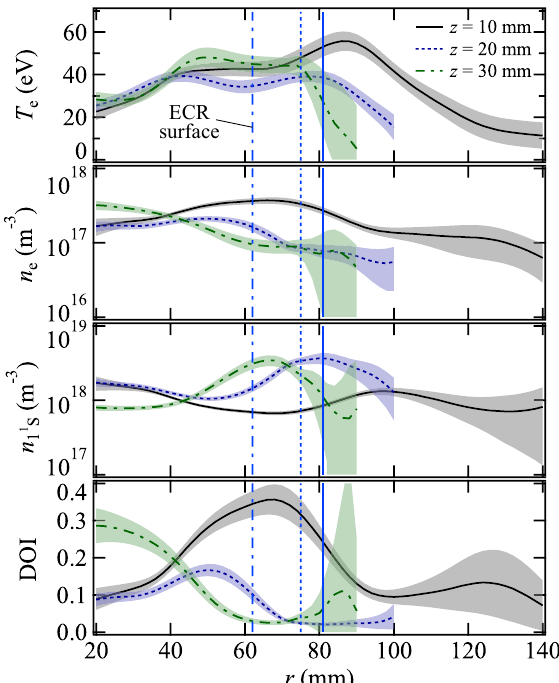
Figure 4. Radial distributions of T e , n e , n 1 1 S and the DOI, with error